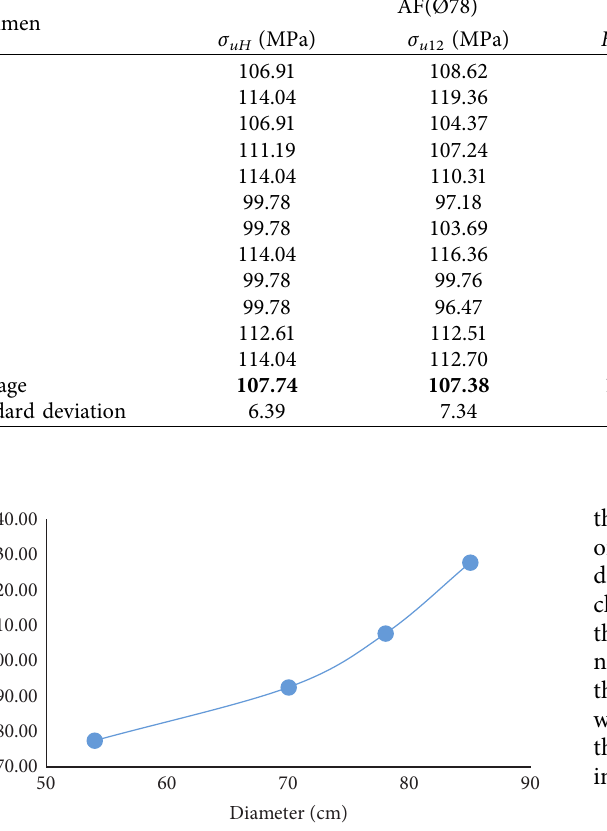
Figure 9: Variation curve of failure stress in 4-point bending per diameter